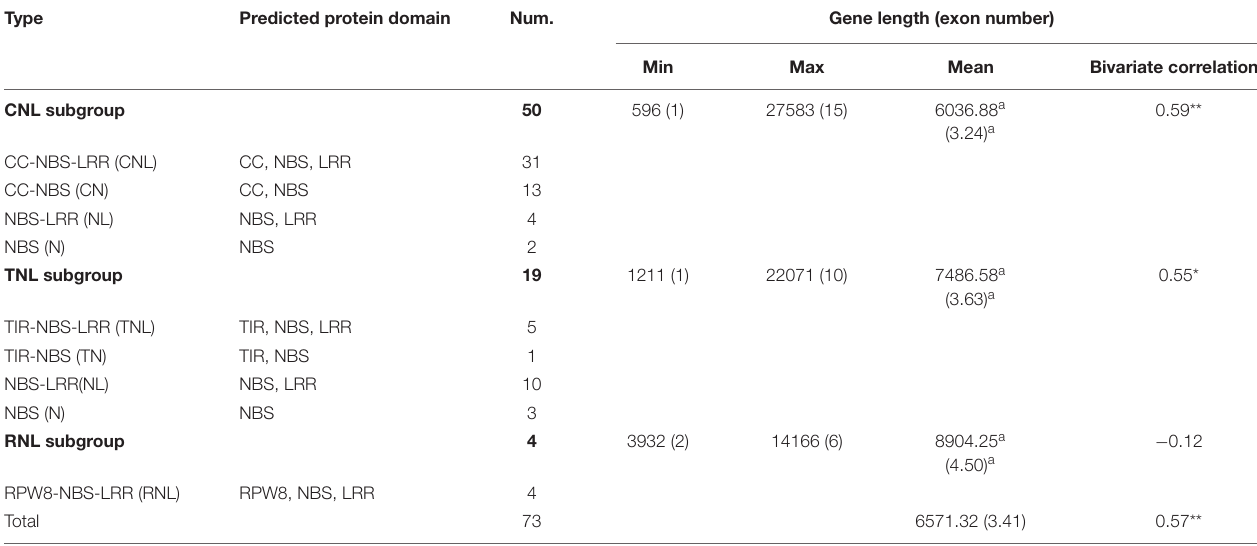
TABLE 2 | Groups of NBS resistance genes in the A . trifoliata genome. Type Predicted protein domain Num.